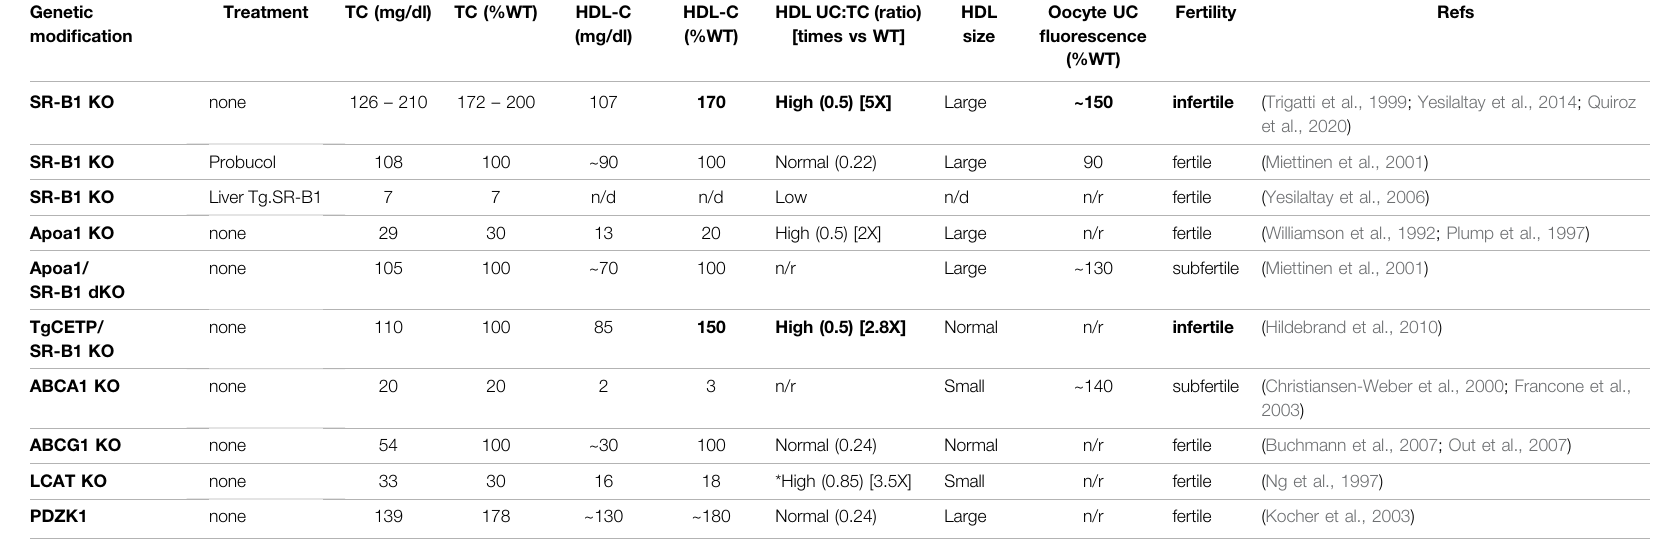
Normal (0.24) fertile (Kocher et al., 2003)